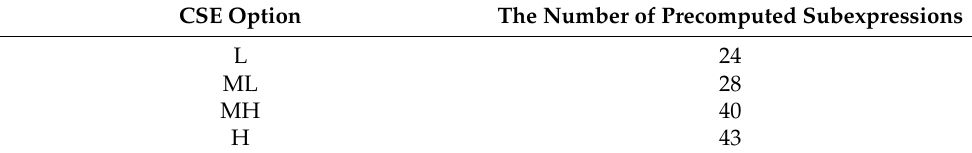
Table 3. CSE option description.